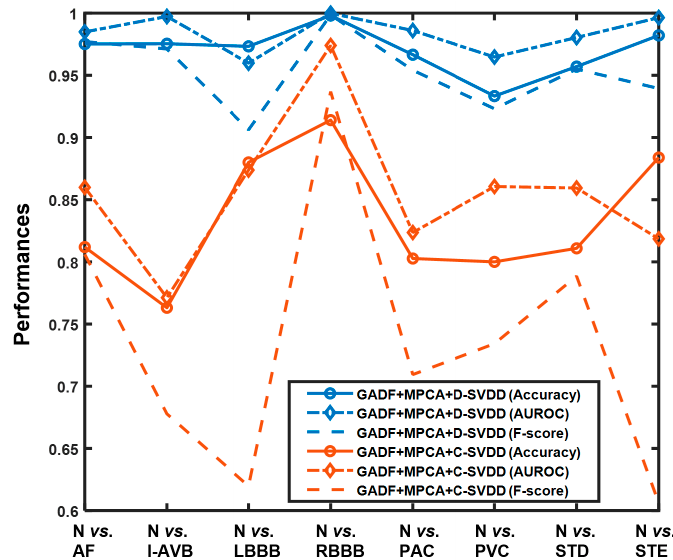
Figure 5. Performance comparison between the proposed framework, i.e., GADF + MPCA + D-SVDD and unsupervised learning without using the deep neural network, i.e., GADF + MPCA + C-SVDD in the benchmark, Category 2.